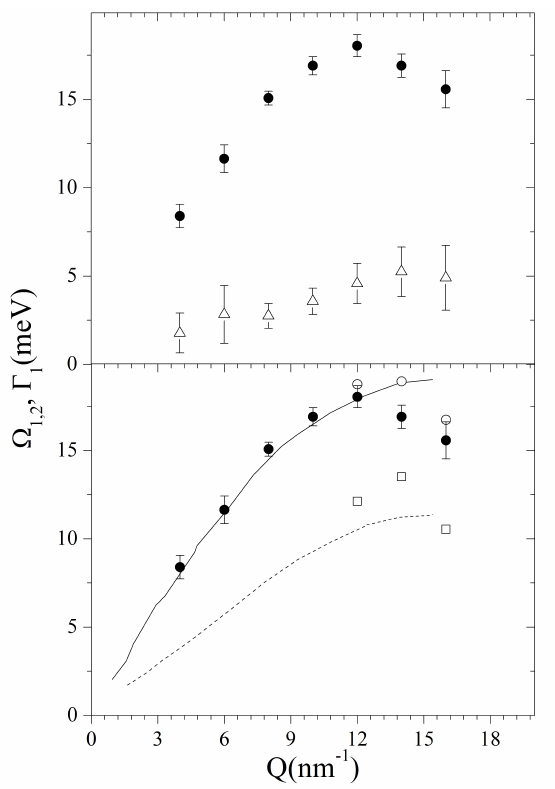
Figure 4. Top panel : Frequency (dots) and damping (triangles) of the acoustic modes of liquid gold as derived through through a DHO-based model and the RJ-MCMC algorithm. Redrawn from Ref. [12]. Copyright (2016) of American Physical Society. Bottom panel : The only mode frequency in liquid gold corresponding to the k = 1 option (see text) as in the top panel (black filled circles) is plotted together with the two frequency dispersions would be obtained at the higher Q values always in liquid gold, if the k = 2 option would be chosen (empty squares and circles) and the acoustic phonon branches measured in solid Au (dashed and solid black